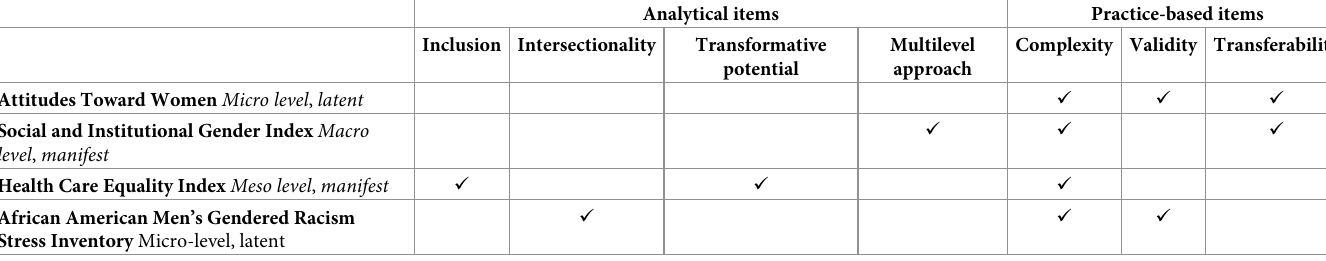
Table 3. Examples of measures and how to use the